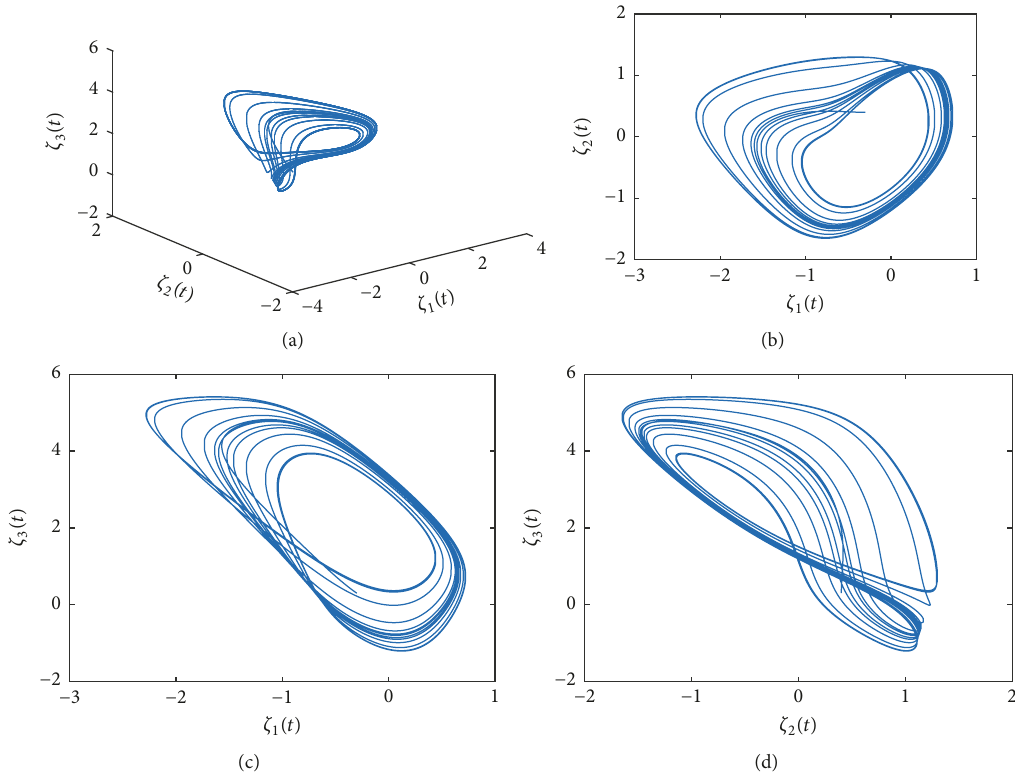
Figure 6: Dynamical behavior of system (43) in (a) 3D space, (b) 𝜁 1 (𝑡) − 𝜁 2 (𝑡) plane, (c) 𝜁 1 (𝑡) − 𝜁 3 (𝑡) plane, and (d) 𝜁 2 (𝑡) − 𝜁 3 (𝑡) plane.